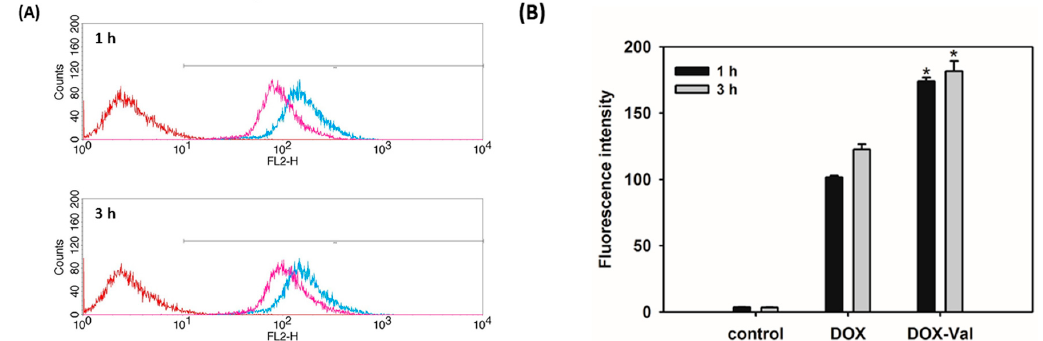
Figure 2. Cellular accumulation efficiency of DOX-Val evaluated by flow cytometry in MCF-7 cells. DOX and DOX-Val (10 μ M) were incubated for 1 h and 3 h in MCF-7 cells. ( A ) Histograms of all experimental groups, control (red), DOX (pink), and DOX-Val (blue), are shown; ( B ) The mean value of the fluorescence intensity of each group is presented. Data are presented as means ± standard deviation ( n = 3). * p < 0.05, compared with DOX group.